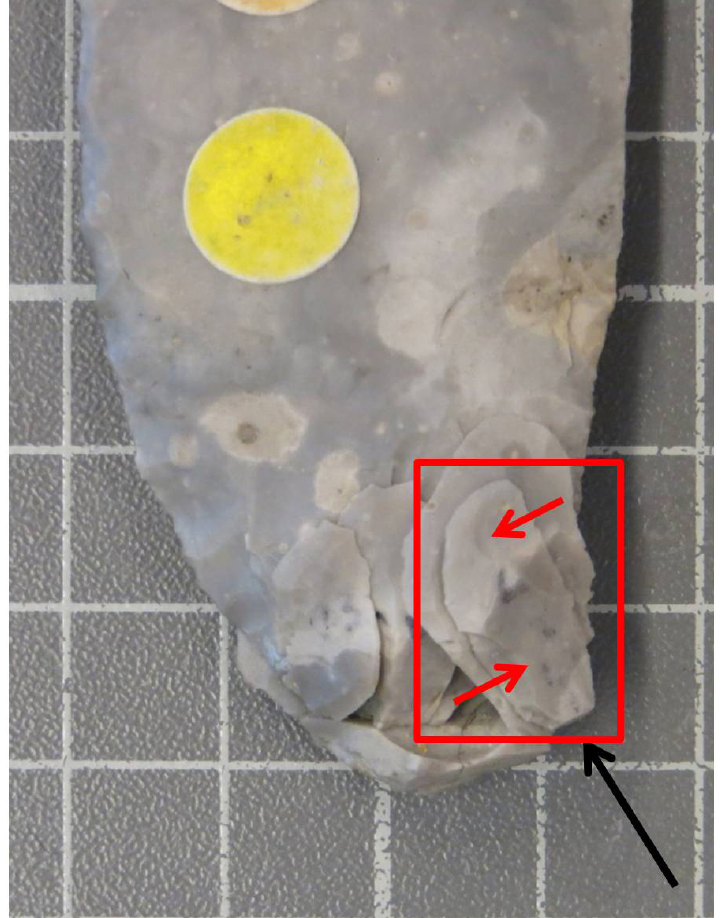
Figure 4. Blade-point 4.2, long flake v2a with red arrows indicating direction of dorsal scars and black arrow indicating direction of removal blow (photograph by the author). Gridlines on this image are 10mm